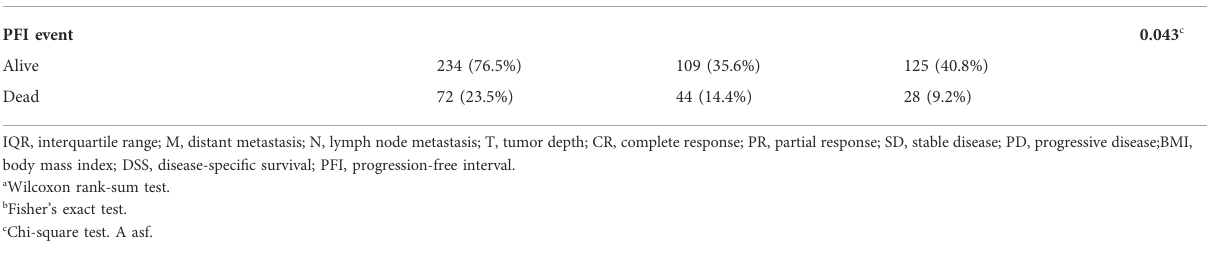
Table 2. We obtained the risk scores of the immune gene signature in each CESC patient according to the proposed formula (Dai et al., 2021) and divided the patients into the high-risk and low-risk groups. The survival time of patients with low-risk scores was signi fi cantly longer than those with high-risk scores, which con fi rmed the prognostic value of the risk score ( p = 1.526e − 06, Figure 7B).